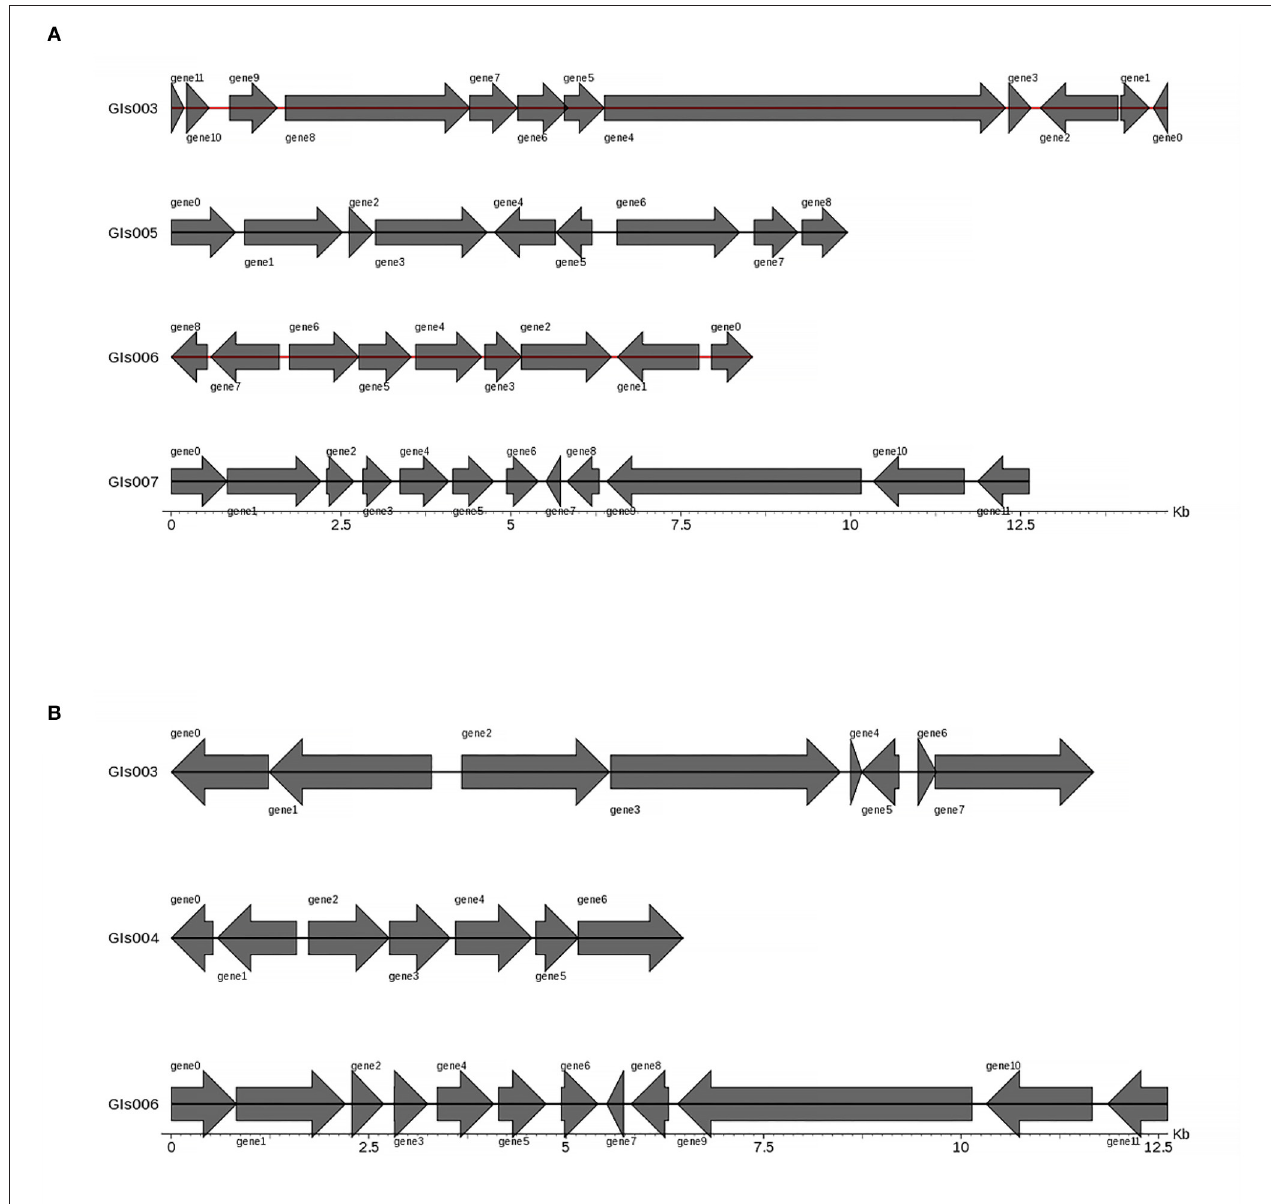
FIGURE 2 | Statistical representation of gene distribution in GIs of Pm3 and Pm64. (A) Predicted GIs structure in Pm3 chromosome. (B) Predicted GIs structure in Pm64 chromosome. The horizontal coordinates are length scales and the lengh of gene islands shown in the figure are <